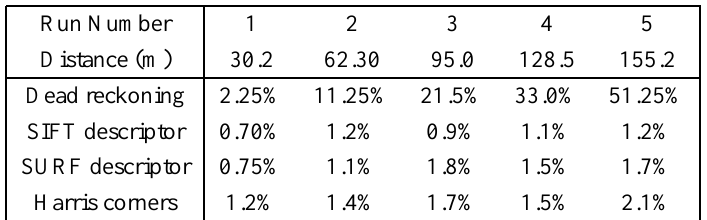
Table 4. Loop closure error in